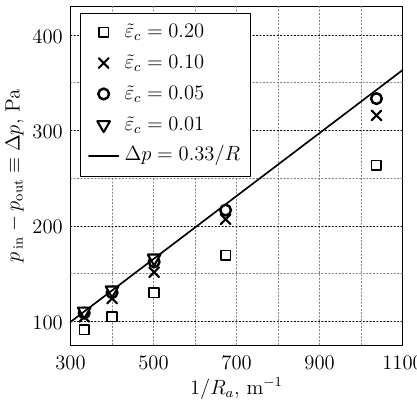
Figure 10. Problem 3.3: dependence of the computed pressure drop ∆p on the computed droplet radius R a for different ˜ ε c